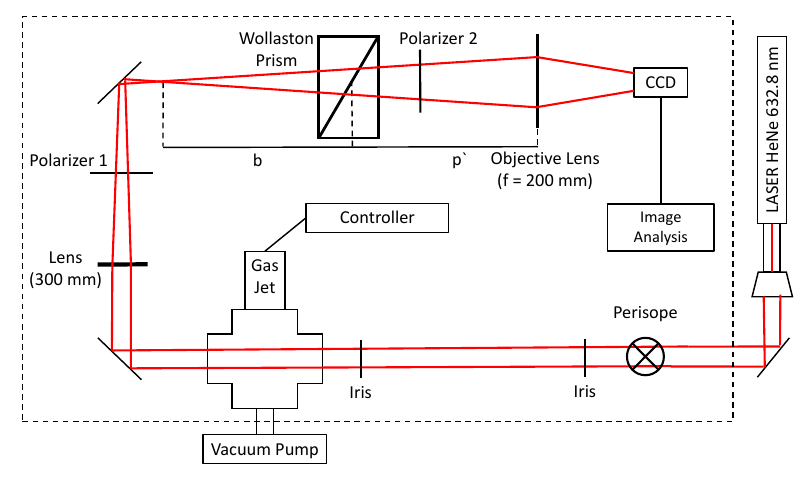
Figure 4. Sketch of the interferometric setup using a Wollaston prism. The dashed line represents the breadboard with the shielding box. The Wollaston prism is mounted on a linear stage, such that the parameter b and therefore the fringe spacing S can be changed (see Section 2). A Nikon imaging lens is attached to the CCD camera.